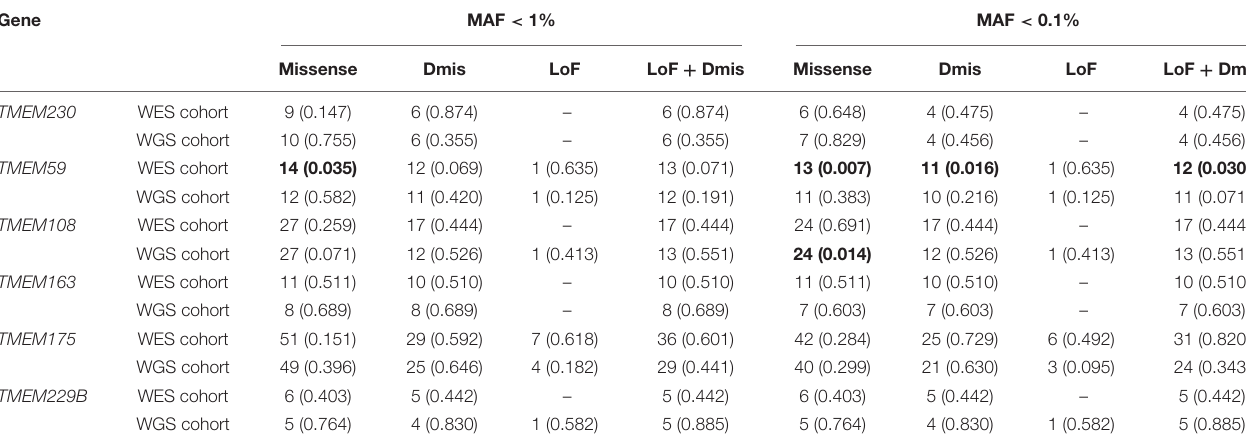
TABLE 1 | Analysis of rare variant burden within targeted genes in Parkinson’s disease.